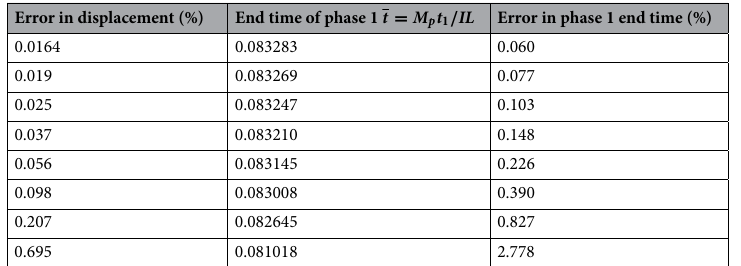
Table 1. Comparison of the theoretical solution of Norman Jones 34 with LCP solution for the case of lumped- mass elements.